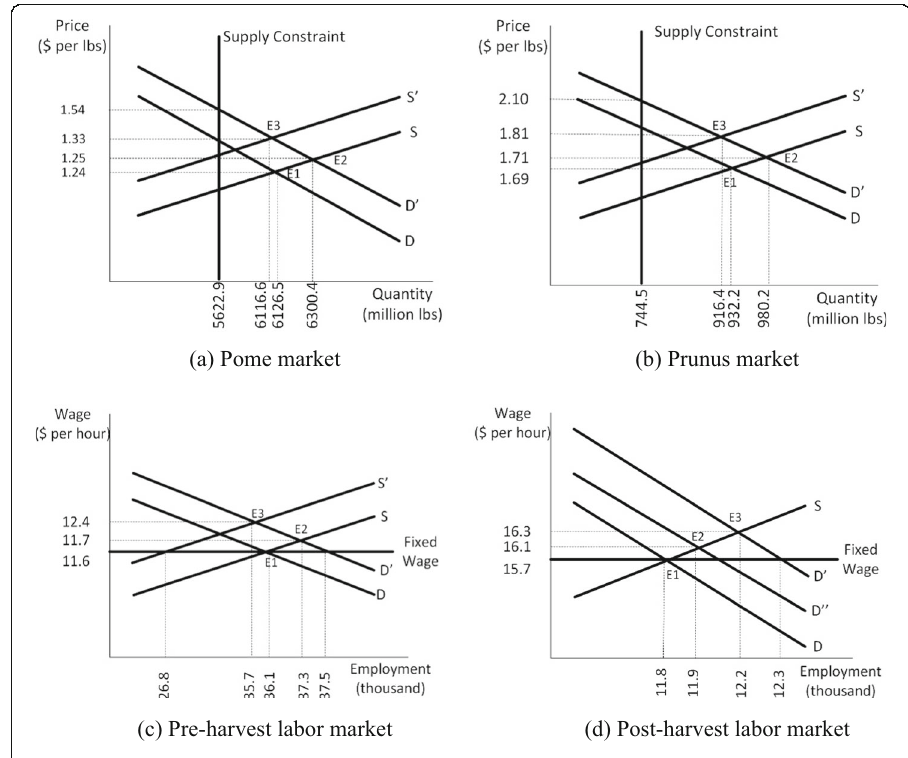
Fig. 2 Illustrative example of post-shock fixed wage scenario for a pome, b prunus, c pre-harvest labor, and d post-harvest labor